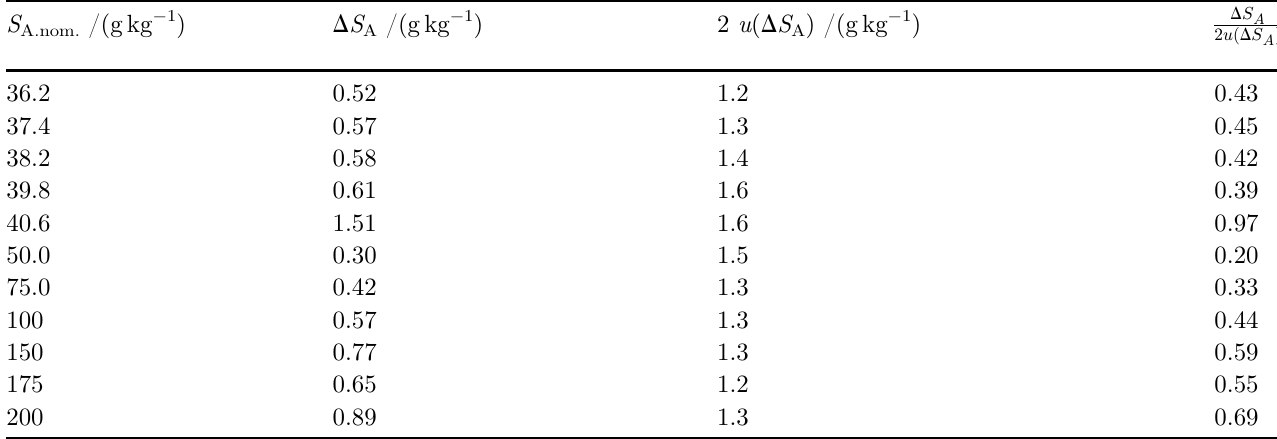
( n ); S ( r )) and the corresponding 2 u ( D S A A